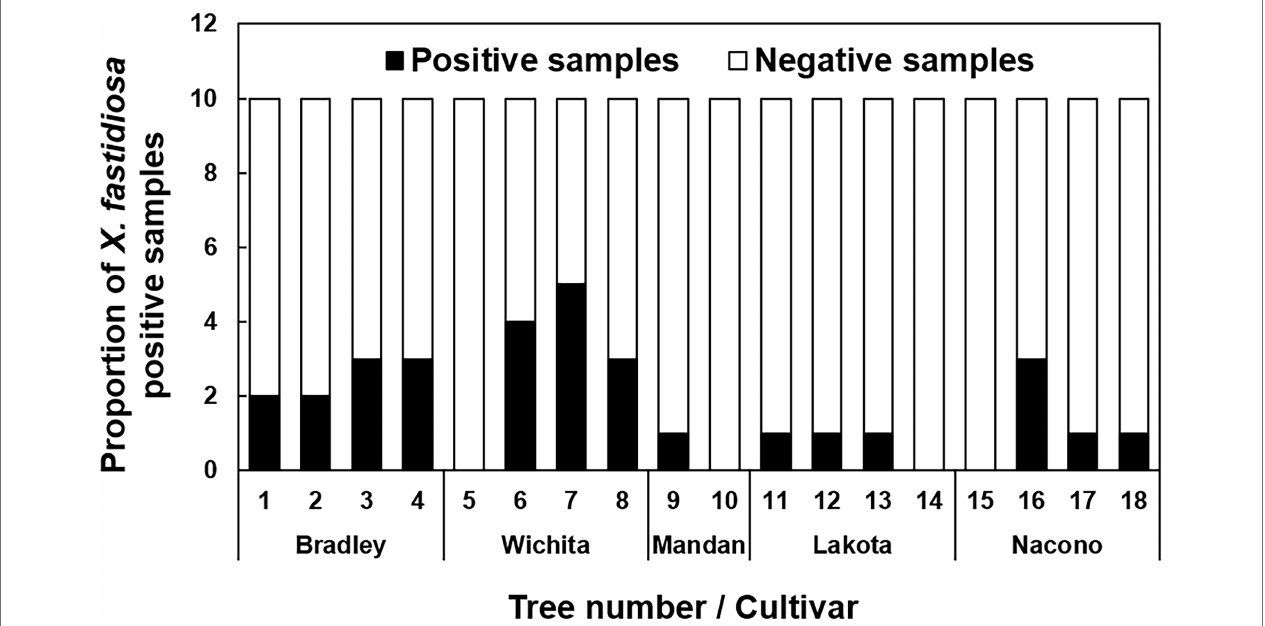
FIGURE 1 | Incidence of pecan liquid endosperm positive for Xylella fastidiosa . Indicates the proportion of seed endosperm that tested positive for the presence of X. fastidiosa . The liquid endosperm of collected pecan seeds from NM and AZ pecan trees were analyzed for the presence of X. fastidiosa using qPCR. A total of 180 seeds were tested. Black bars indicate the total number of samples that tested positive per the total number of samples